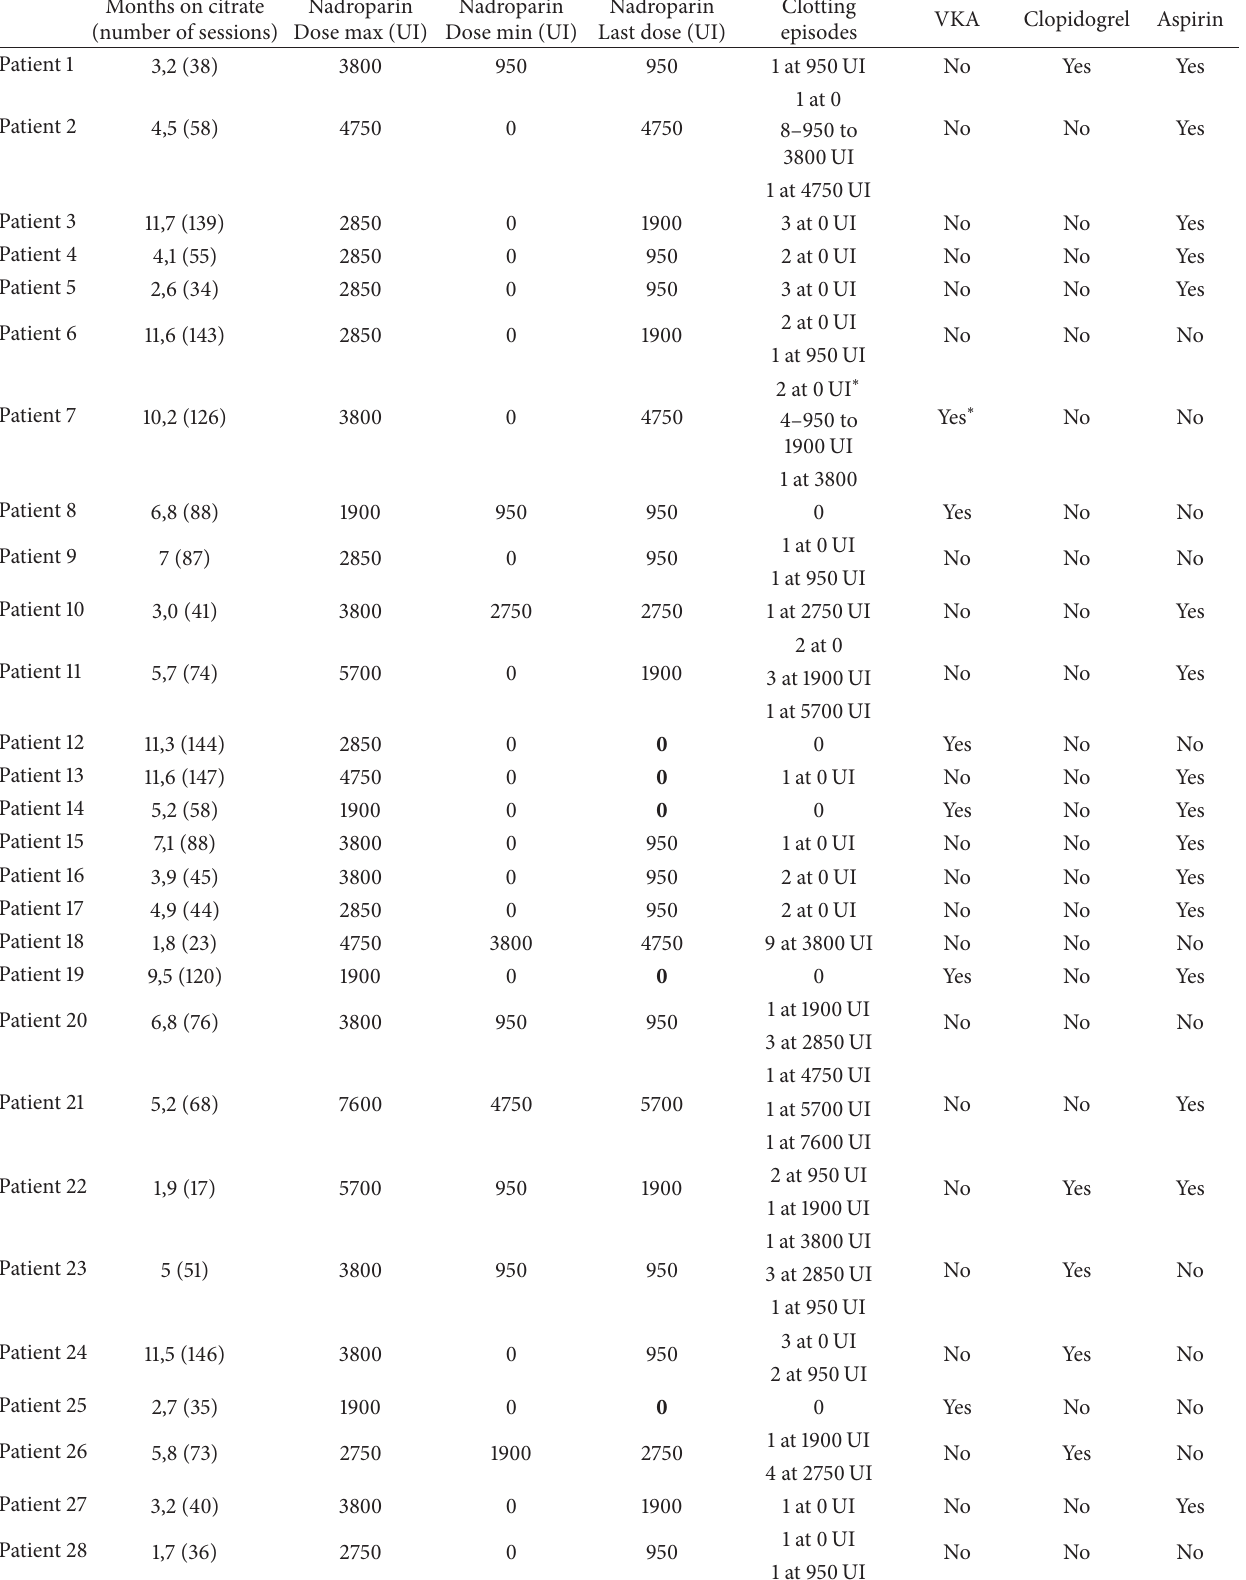
Table 2: Nadroparin use and clotting episodes